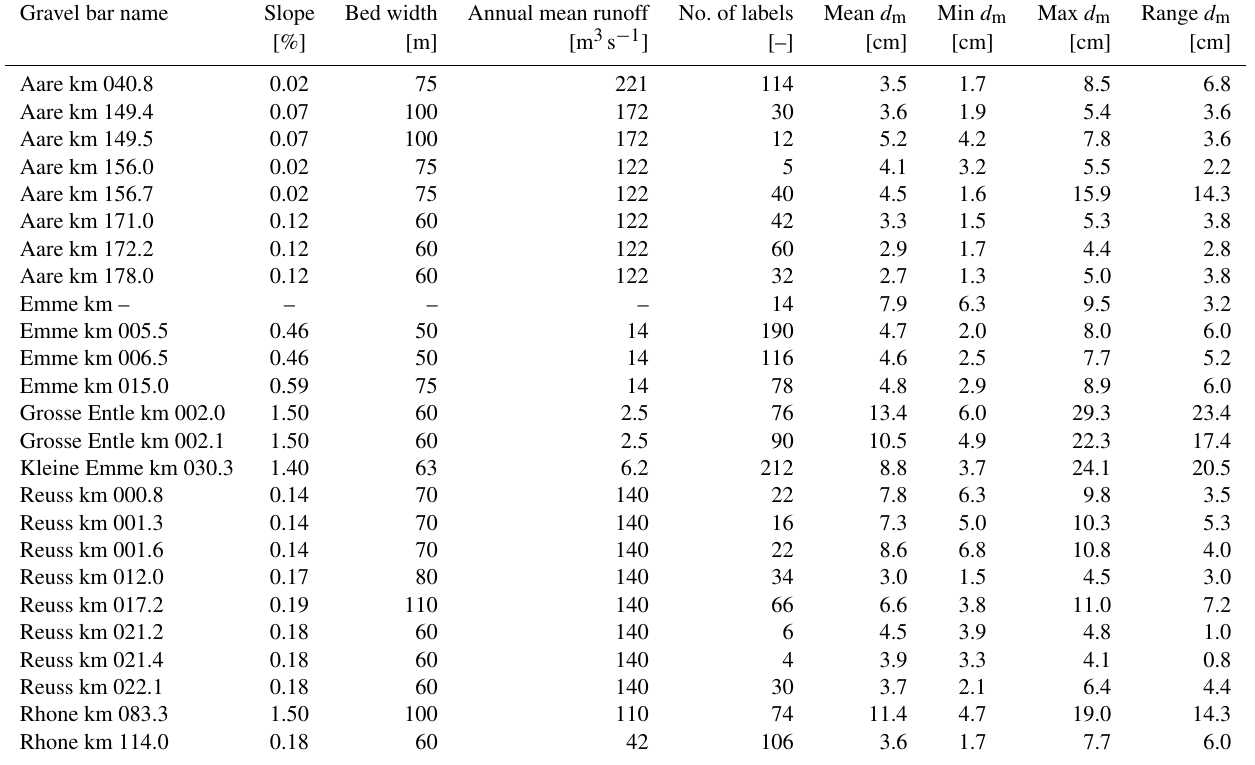
Table B1. Overview of the 25 investigated gravel bars. From left to right: slope and bed width of the river at this location with the corre- sponding annual mean water runoff. Number of annotated image tiles ( digital line samples ). Ground truth statistics of the characteristic mean diameter d m